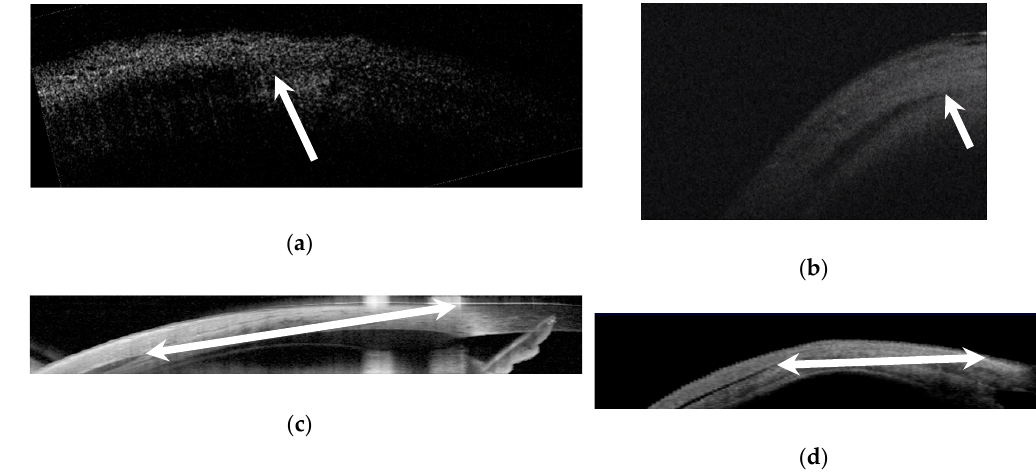
Figure 1. Anterior segment optical coherence tomography of a lateral rectus muscle insertion: ( a ) Bioptigen, ( b ) Rescan, ( c ) Spectralis, and ( d ) Visante. The rectus muscle insertion was located as a dark structure tapering toward the limbus between the sclera and conjunctiva / Tenon’s. Arrows mark the insertion in ( a , b ); the limbus was identified intra-operatively, and then measured to the insertion on the optical coherence tomography (OCT) with handheld calipers. Double arrows mark the insertion and limbus in ( c , d ), and calipers on the machine measured the distance.